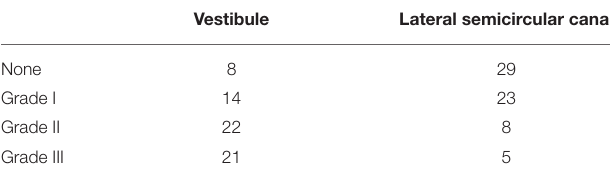
TABLE 2 | EH grade in vestibule and lateral semicircular